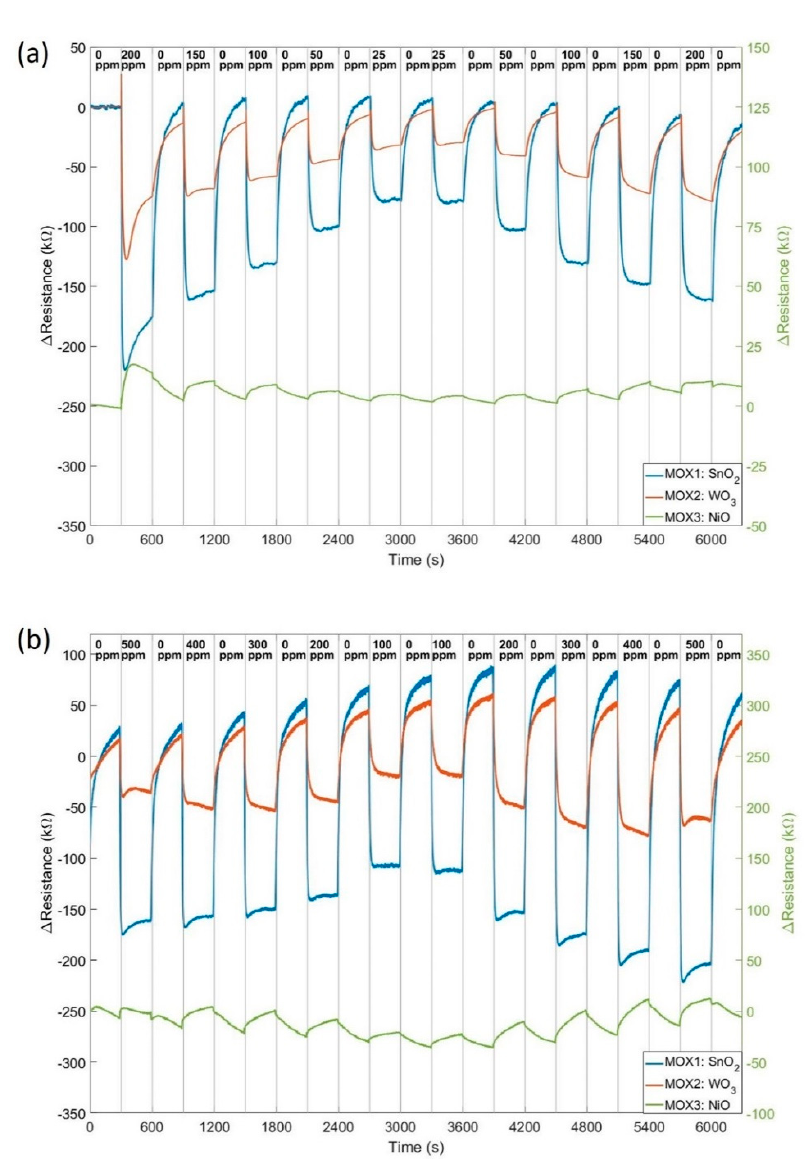
Figure 3. Change of resistances of three MOX sensors (Pt/Pd doped SnO 2 , WO 3 and NiO) towards ( a ) acetone from 25 ppm to 200 ppm in 5 min steps, and ( b ) ethanol from 100 ppm to 500 ppm in 5 min steps. Synthetic air baseline between gases, both under dry condition.